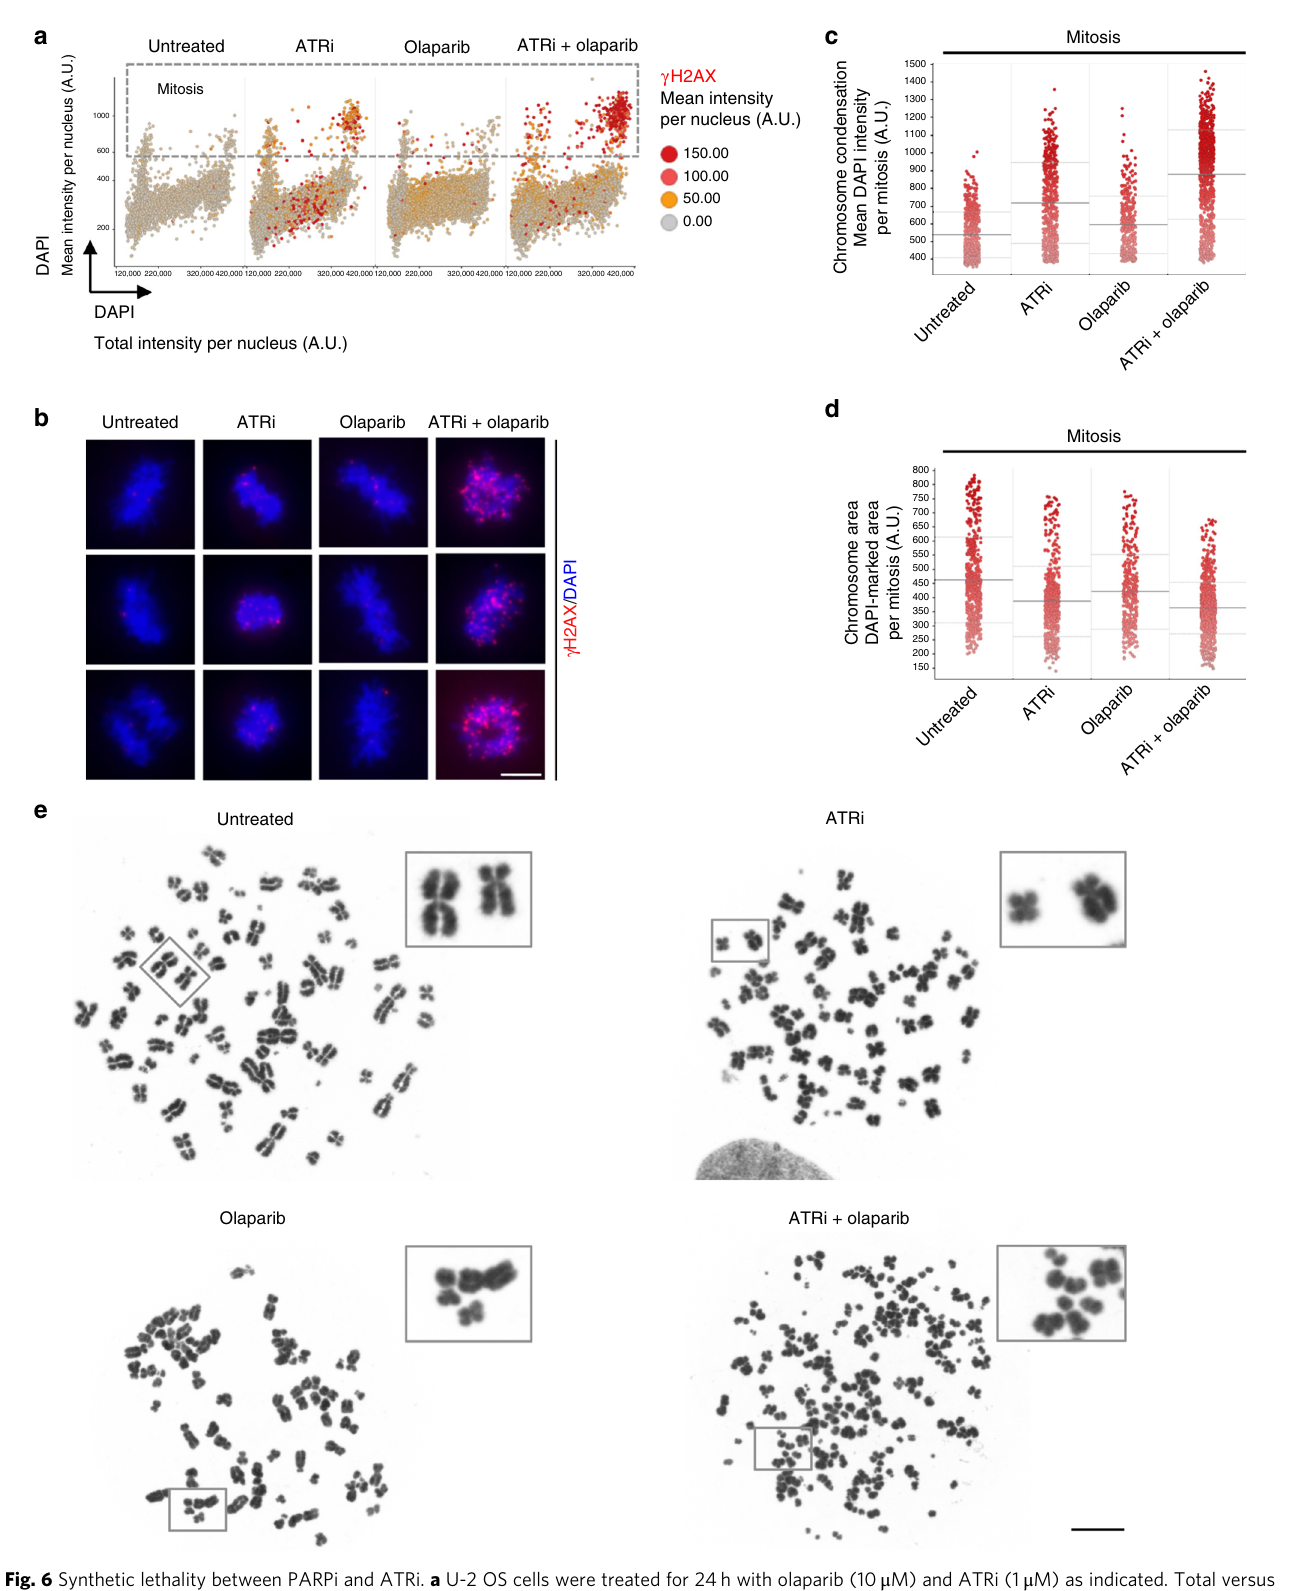
Fig. 6 Synthetic lethality between PARPi and ATRi. a U-2 OS cells were treated for 24 h with olaparib (10 μ M) and ATRi (1 μ M) as indicated. Total versus mean DAPI intensities color-coded for γ H2AX are shown. Mitotic cells are characterized by 4C (prophase to metaphase) or 2C (anaphase to telophase) DNA content and an increased mean DAPI intensity. b Representative images of mitotic cells after single and combined treatment. c Mean DAPI intensities of mitotic cells as a measure of chromosome condensation are shown. Horizontal lines represent population averages ± s.d. d Chromosome area of mitotic cells. Horizontal lines represent population averages ± s.d. e Metaphase spreads of cells treated as indicated. Color codes as de fi ned in the fi gure panels. Scale bars, 10 μ